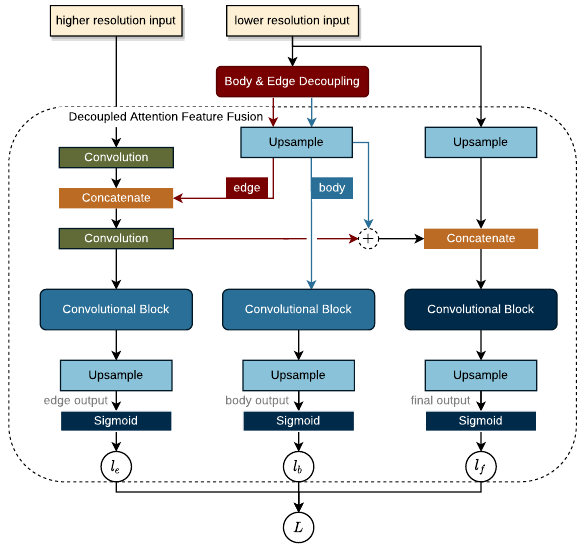
Figure 3. Body and Edge feature fusion. Model final outputs.